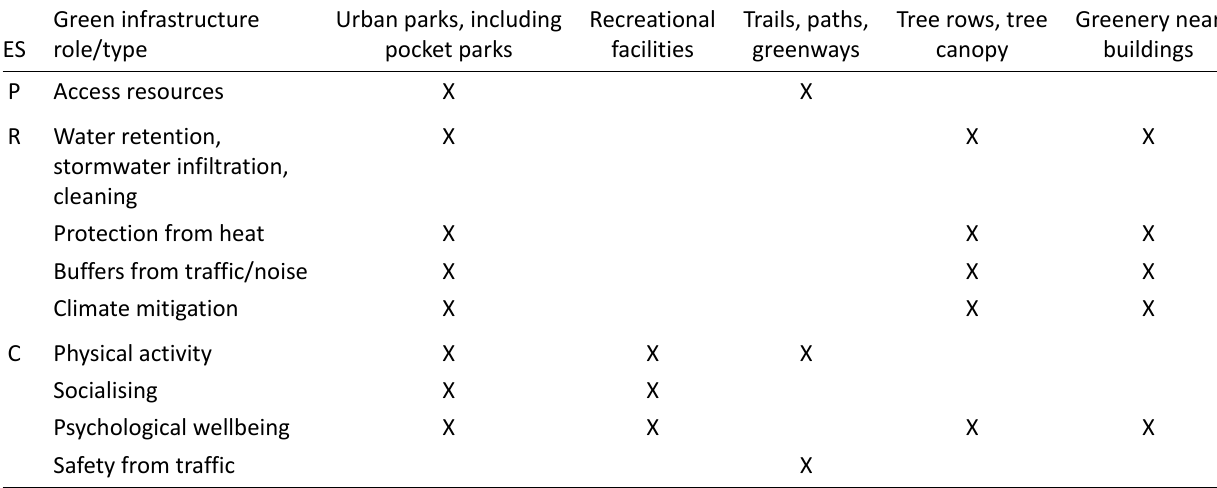
Table 1. Forms of urban greenery in residential estates versus their role and ecosystem services. Green infrastructure Urban parks, including Recreational Trails,